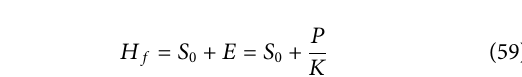
FIGURE 7 | Effect of the shape factor and friction factor on the stress state coef fi